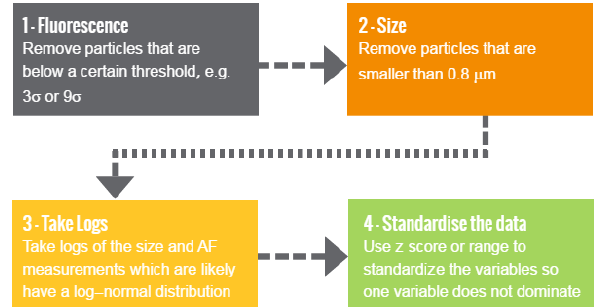
Figure 2. Overview of preprocessing steps for WIBS